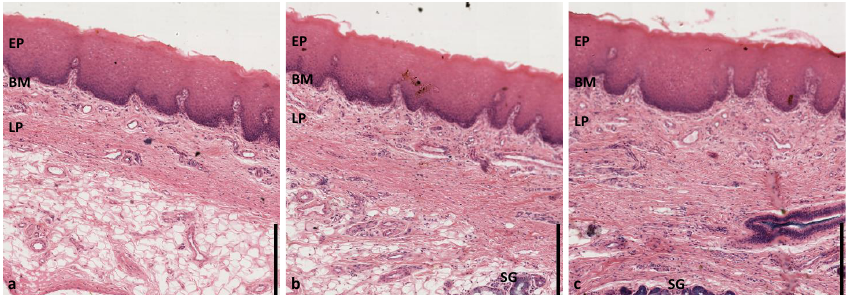
Figure A8. Supplementary HE stained histological cross sections of the mucosal tissue of the human hard palate [44]. EP: epithelium, BM: basement membrane, LP: lamina propria, SG: salivary gland. Scale bar: 200 µ m.